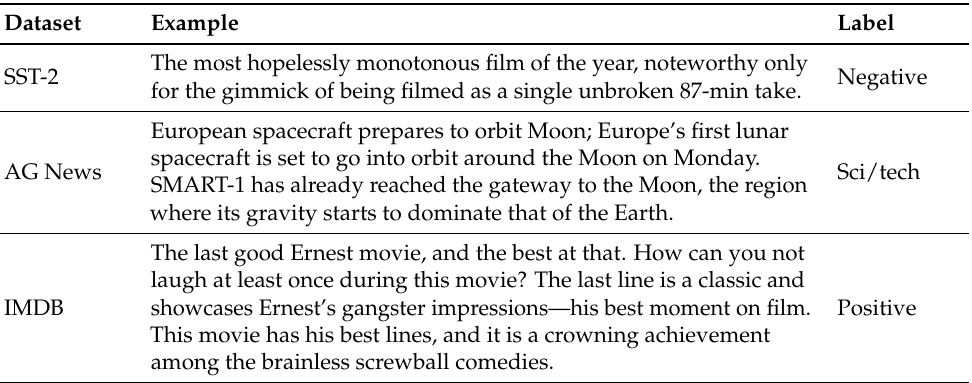
Table 1. Dataset